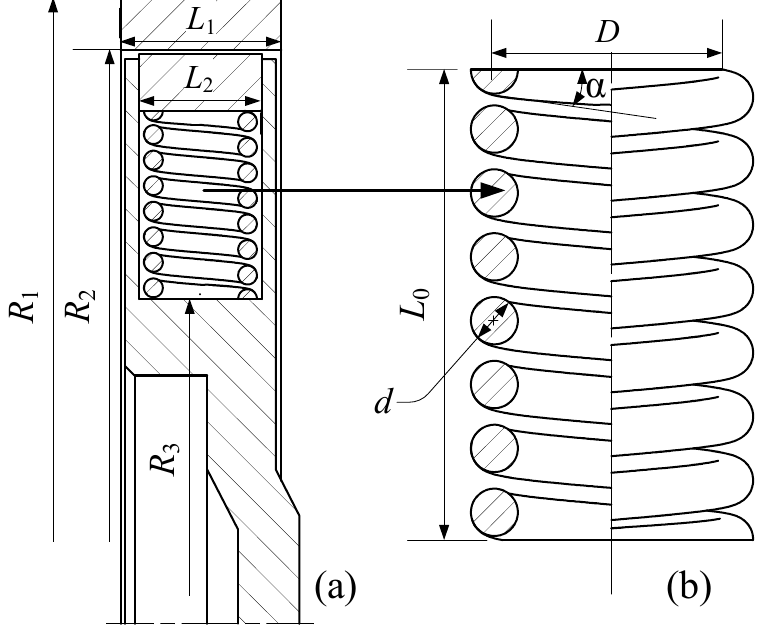
Figure 3. FEM analysis simplified model. ( a ) Schematic diagram of simplified model; ( b ) Simplified spring model.